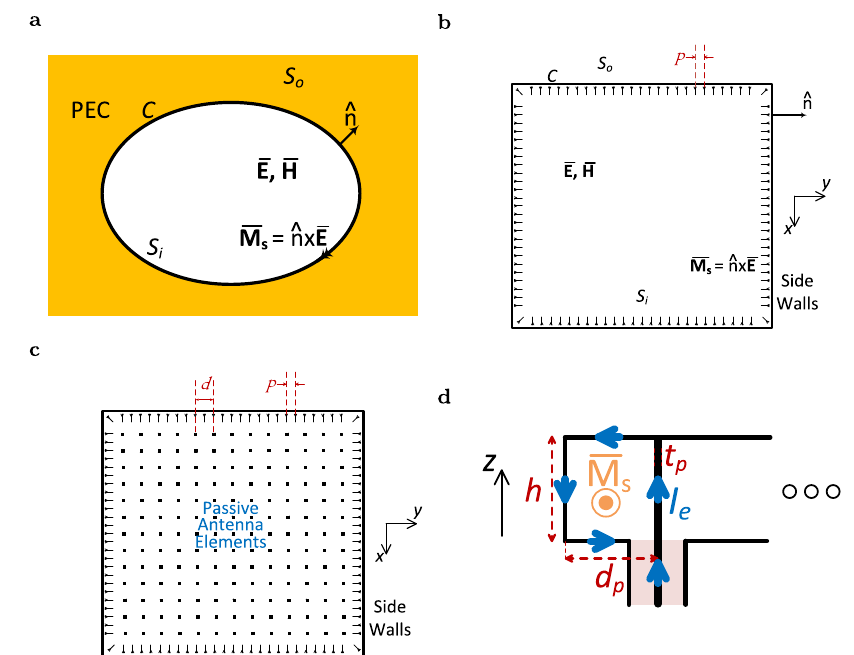
Fig. 1 PEX array concept. a A general depiction of Schelkunoff ’ s equivalence principle with magnetic surface currents lining the periphery of a region surrounded by a perfect-electric conductor (PEC). The electromagnetic fi elds inside the region are solely determined from the tangential magnetic surface currents on the Contour C . b A general illustration of the Huygens' Box, which is a practical implementation of Schelkunoff ’ s equivalence principle using a metallic cavity. c A general schematic depiction of the PEX antenna array, which is essentially a Huygens' Box with additional passive antenna elements (slots) on the top side, allowing the plane waves underneath to radiate. d Side view of the proposed peripheral PEC-backed effective magnetic current sources which inject a circulating electric current into the side walls of the metallic cavity. They are created using a coaxial feed, and are used to realize the peripheral Huygens' sources required for the PEX cavity. (Dimensions: p = 7.15 mm, d = 14.3 mm, ϵ r = 2.2, d p = 5.5 mm, t p = 1.4 mm, and h = 1.575 mm on a Rogers RT/duroid 5880 1oz